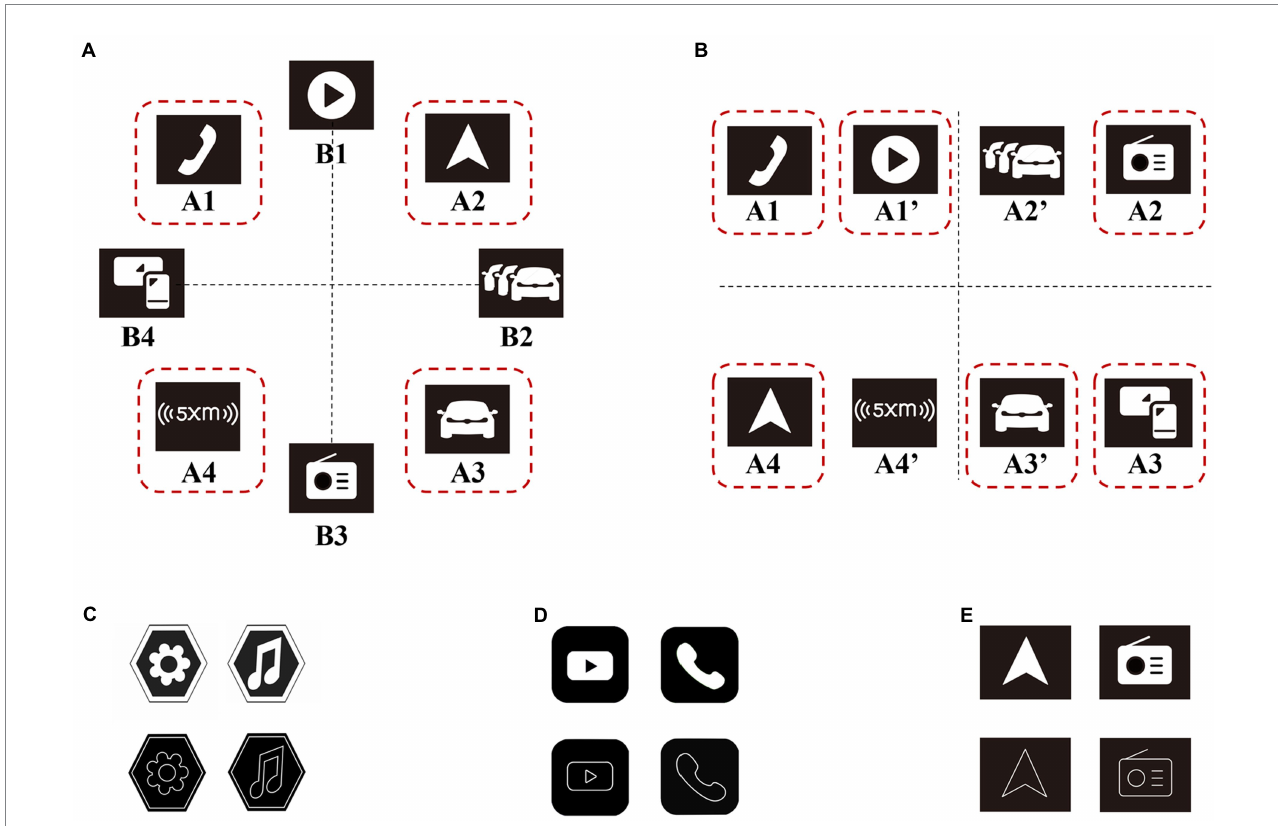
FIGURE 2 Locations of icons in different layout methods (taking Tesla brand as an example), and target search icons for different brands. (A) Locations of icons in circular layout, and the locations in the red dashed box are the optional locations of the target icons. (B) Locations of icons in rectangular layout, and the locations in the red dashed box are the optional locations of the target icons. Note: The dashed lines and dashed boxes did not appear in the experimental stimuli, and appeared in this figure only to facilitate the readers’ understanding. (C) Two target search icons in Jeep: “Setting”, “Music”. (D) Two target search icons in Geely: “Video”, “Phone”. (E) Two target search icons in Tesla: “Navigation”,